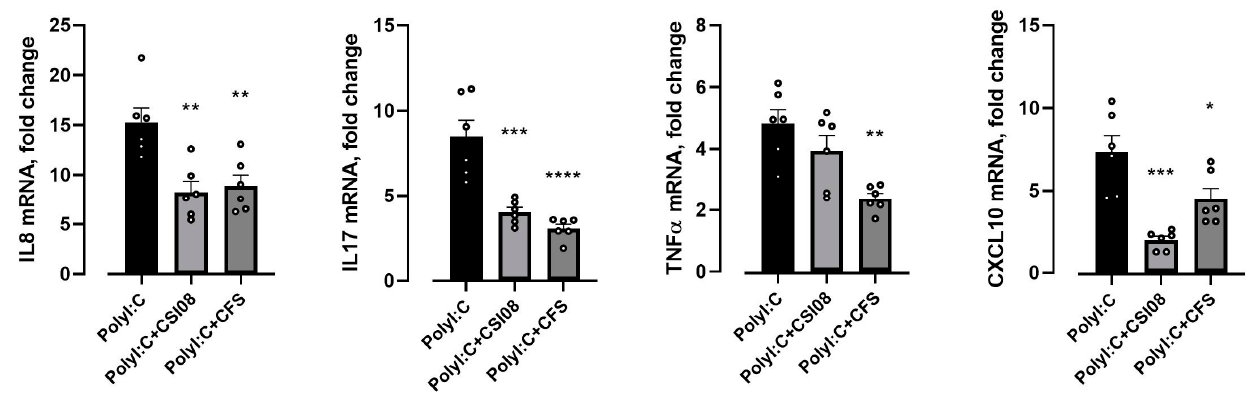
Figure 7. B. clausii CSI08 attenuated the Poly I:C-triggered pro-inflammatory response in HT-29 cell line. qPCR analysis of IL-8, TNF- α , IL-17C, and CXCL10 gene expression 4 h after exposure to 10 µg/mL Poly I:C in HT-29 cells preincubated with B. clausii CSI08 or its cell free supernatants (CFS). * p < 0.05, ** p < 0.01; *** p < 0.001, **** p < 0.0001. Results show mean (n = 6) ± SEM.